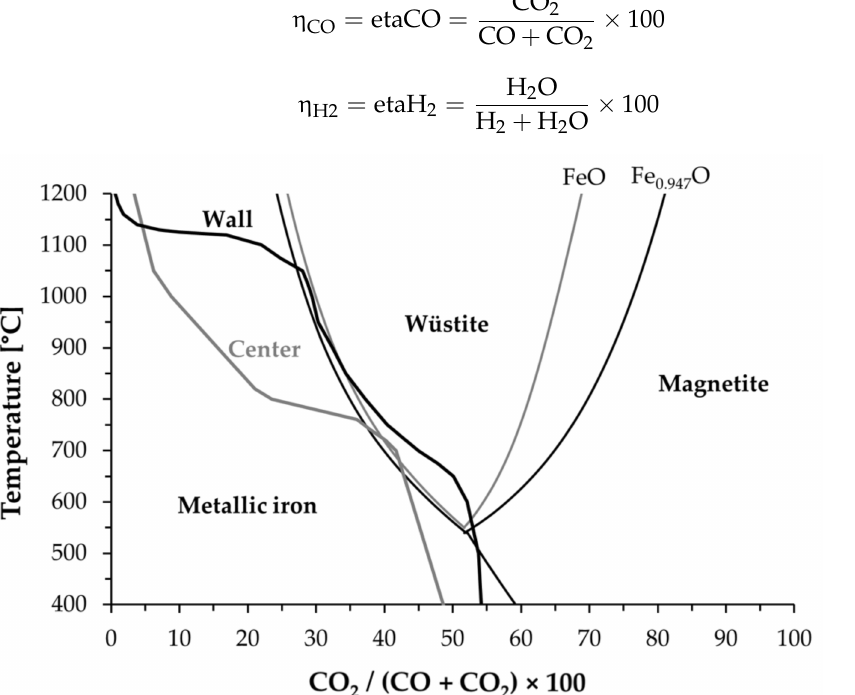
Figure 1. A typical gas composition—temperature operation line for wall and center gas flows in an operating furnace, shown in a Fe-O-C phase diagram, in the manner of Geerdes et al. [11] (p.